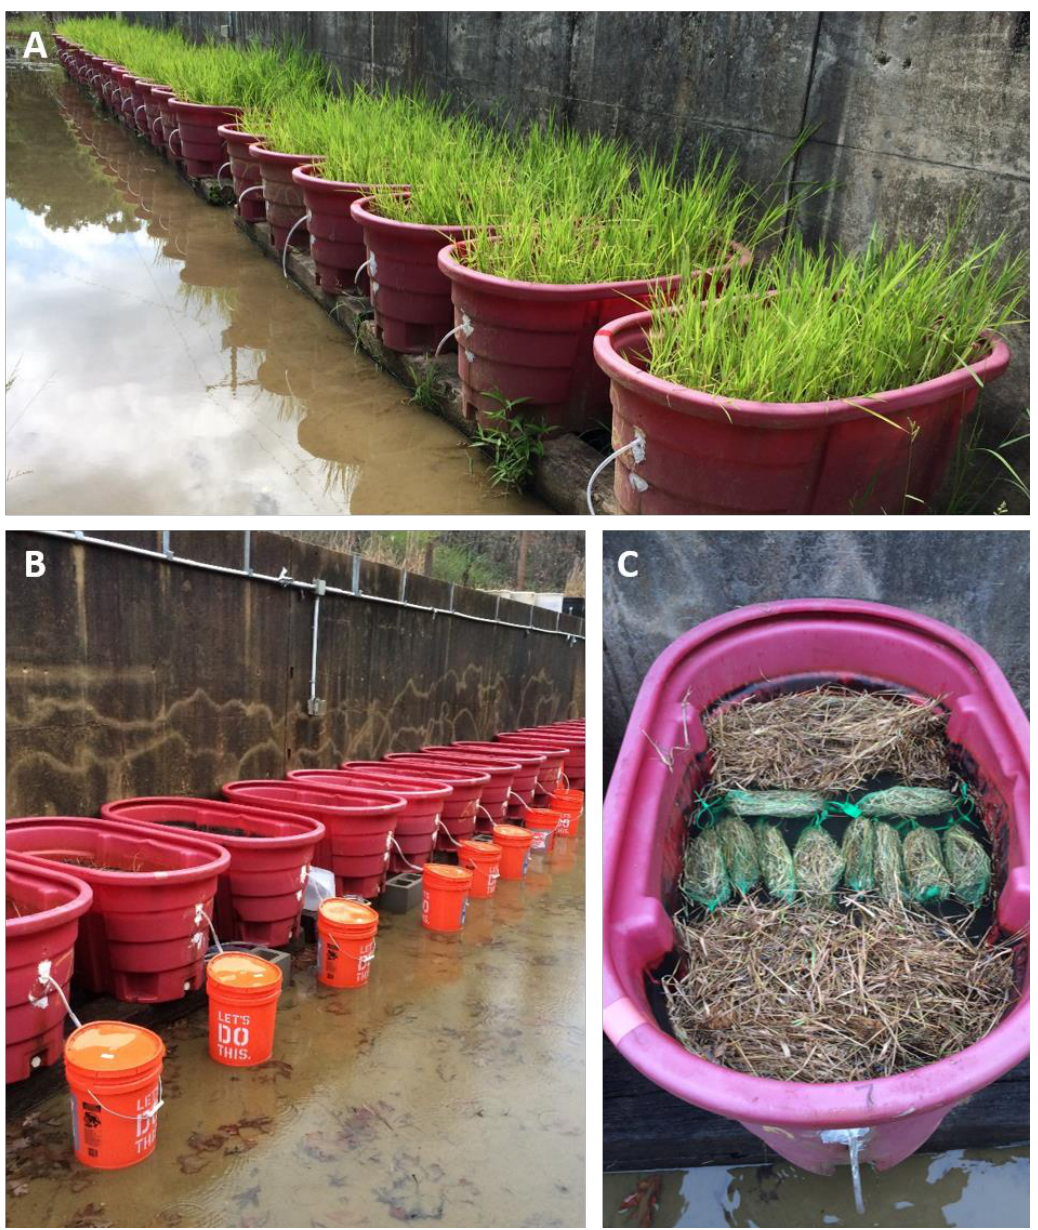
Figure 1. Experimental vegetated mesocosms during the summer growing season ( A ), winter stormwater runoff measurements ( B ), and organic matter breakdown experiment ( C ).